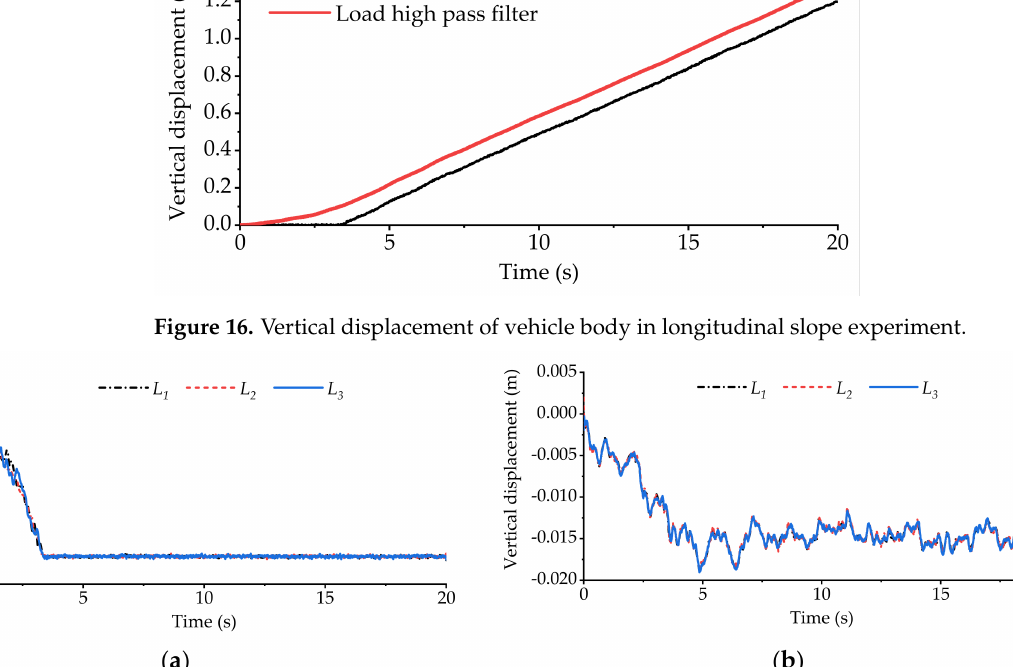
Figure 17. The displacement of equivalent suspension servo actuator cylinder when only vertical displacement is used as input in the longitudinal slope experiment: ( a ) displacement of equivalent suspension servo actuator cylinder without high-pass filter; ( b ) displacement of equivalent suspension servo actuator cylinder when high-pass filter is